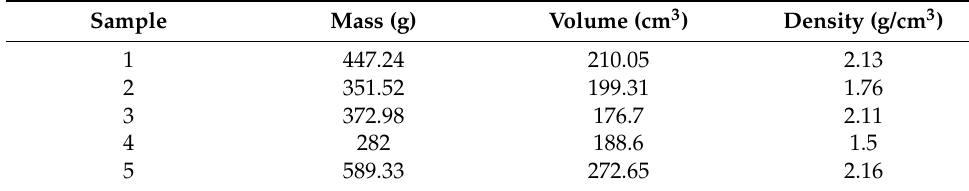
Table 2. Physical parameters of the tested samples.